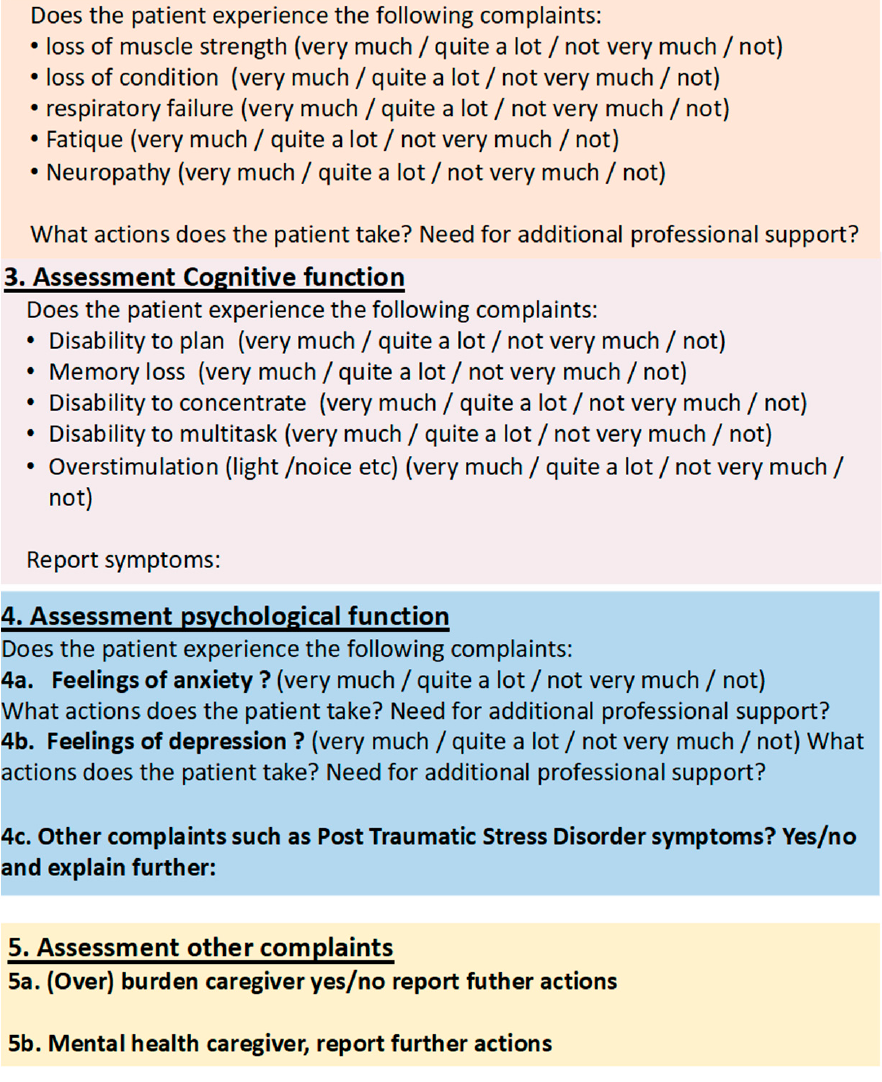
Figure A1. Structured Telephone Service Post-ICU COVID-19.